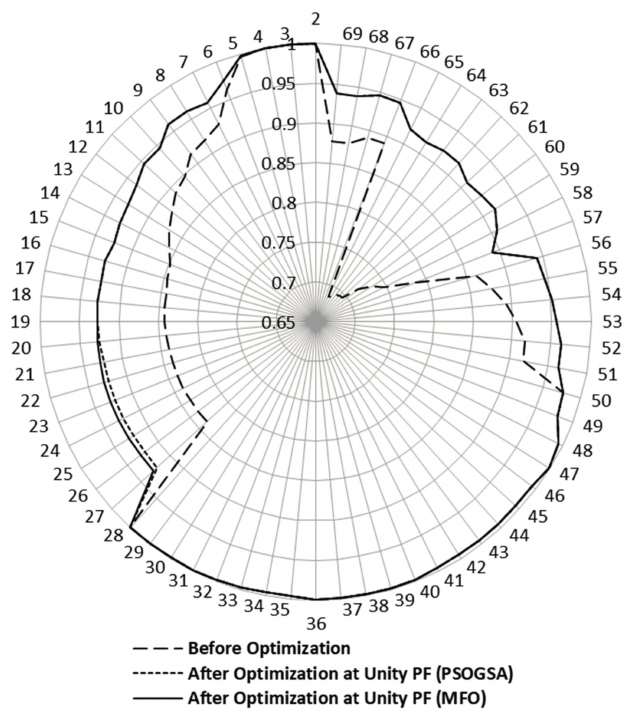
Figure 24. The impact of compensated devices on VSI profile for 69-bus IEEE system at unity PF.